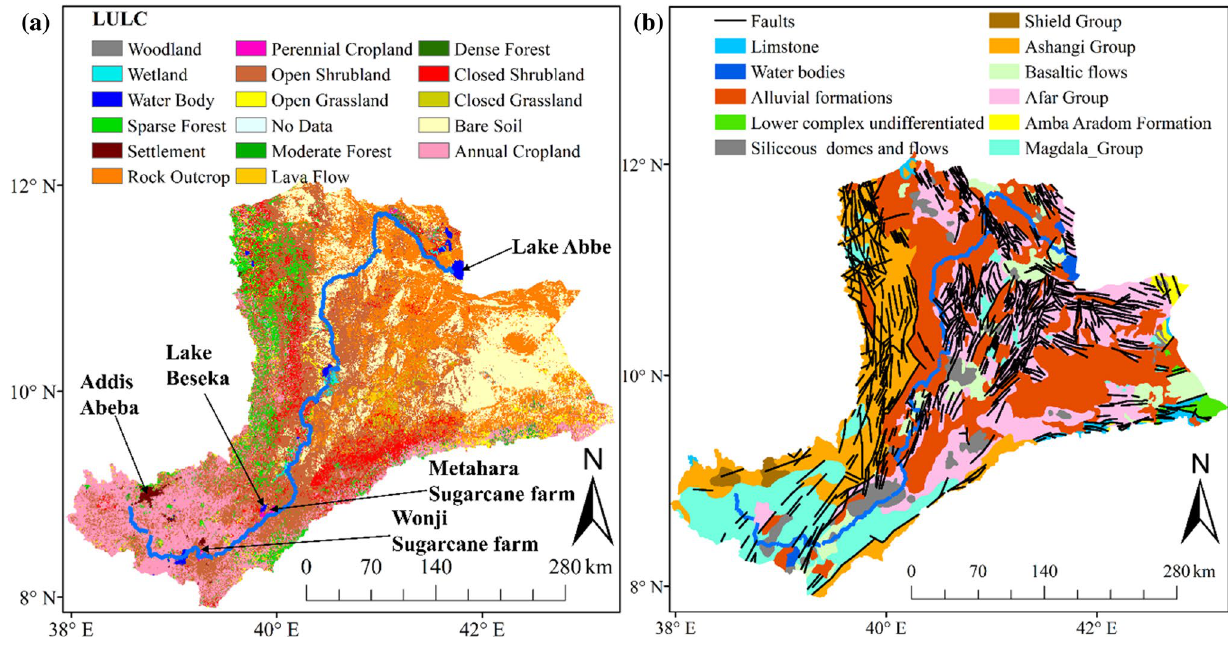
Fig. 2 a Land use land cover and b surface geological maps of the Awash River